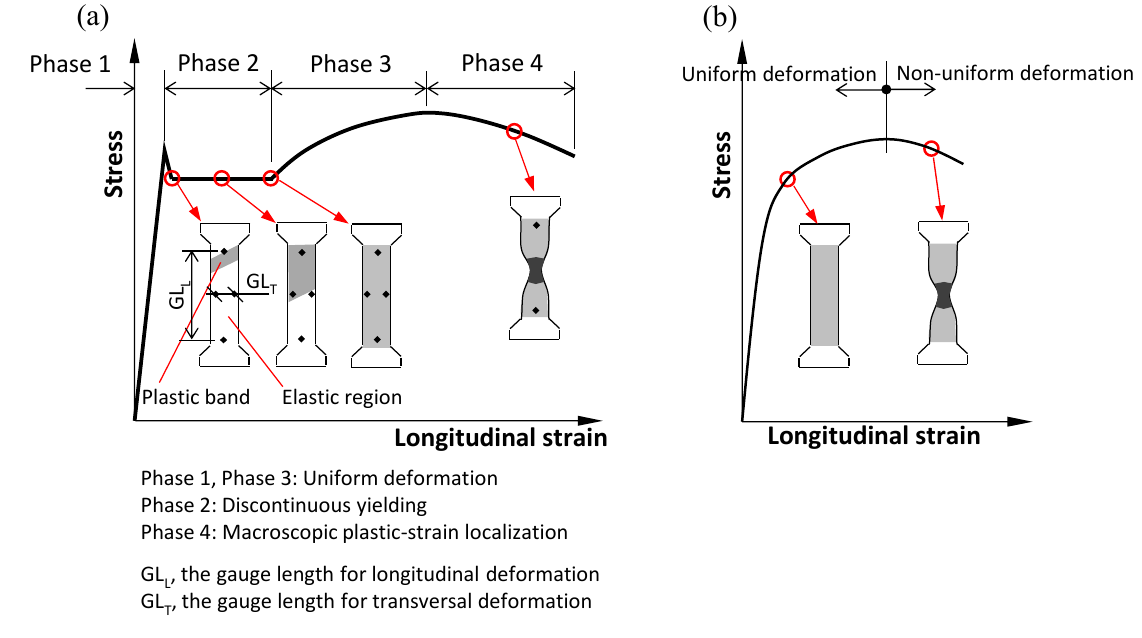
Figure 1. Illustration of two typical deformation processes via the stress–strain curve with discon- tinuous yielding ( a ) and with continuous yielding ( b ).